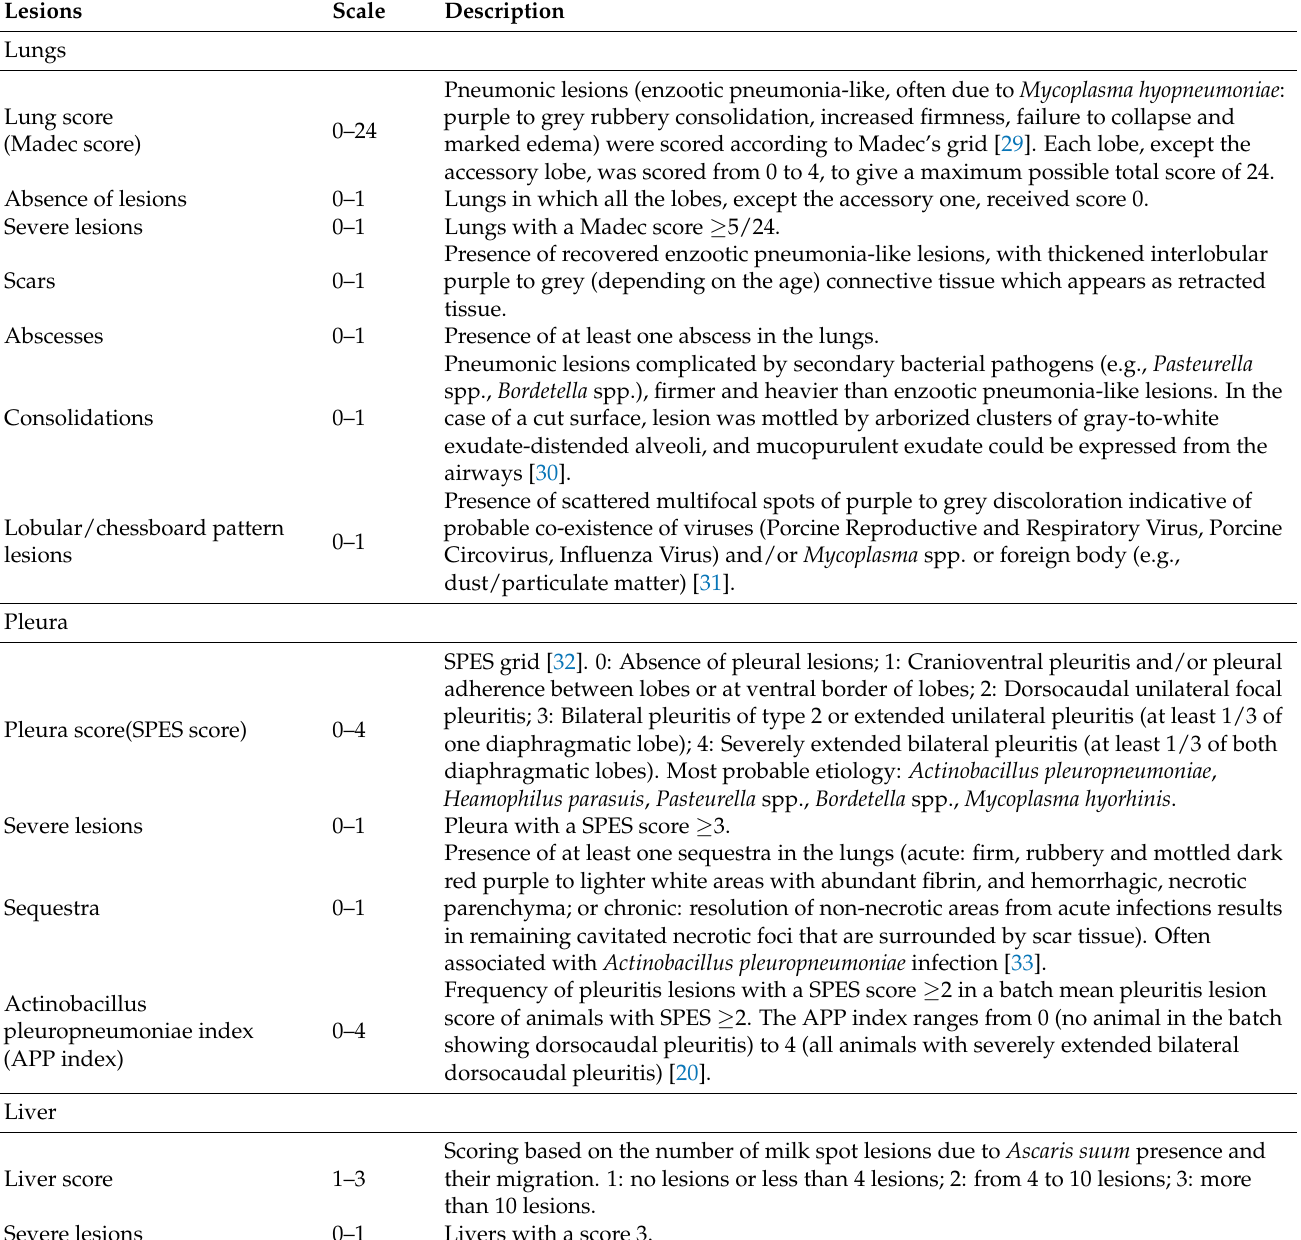
Table 2. The scoring system used for pluck lesion evaluation at slaughter in Italian heavy pigs. Each batch comprised a group of about 135 (minimum 130; maximum 140) pigs from the same holding that were slaughtered on the same day. Lesions were scored on around 100 pigs in each